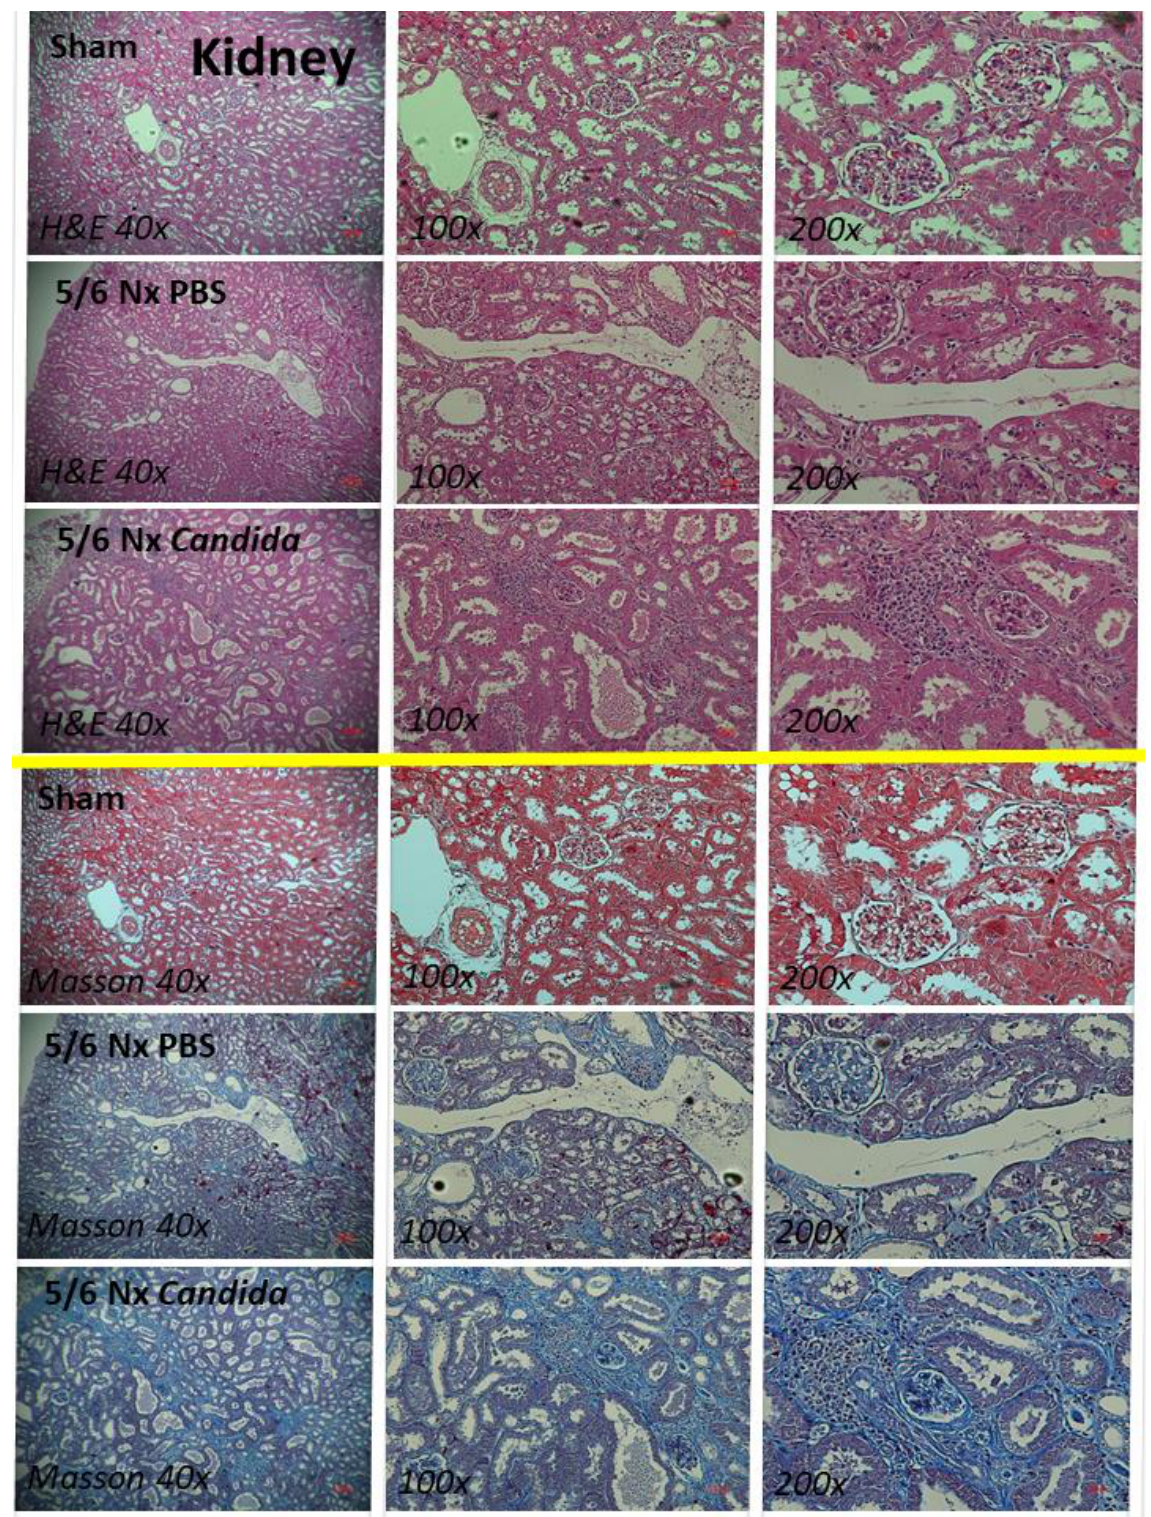
Figure 3. The representative kidney histopathological pictures stained by hematoxylin and eosin (H&E) ( upper part ) or Masson’s trichrome color ( lower part ) (original magnification 40 – 200×) of Sham control, 5/6 nephrectomized mice with phosphate buffer solution (5/6 Nx PBS) or Candida administration (5/6 Nx Candida ) are demonstrated.